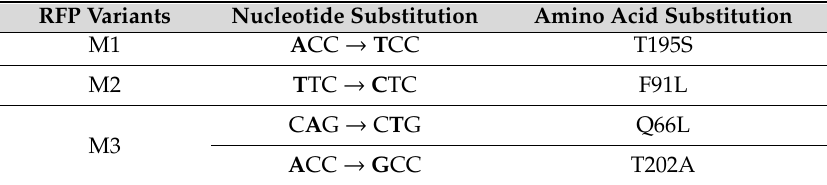
Figure 5. Normalized absorption spectra of mRFP1 wild type (WT; red) and the three variants [M1 (green), M2 (purple), and M3 (blue)]. Table 3. Nucleotide and amino acid substitutions found in the three isolated RFP variants (M1, M2, and